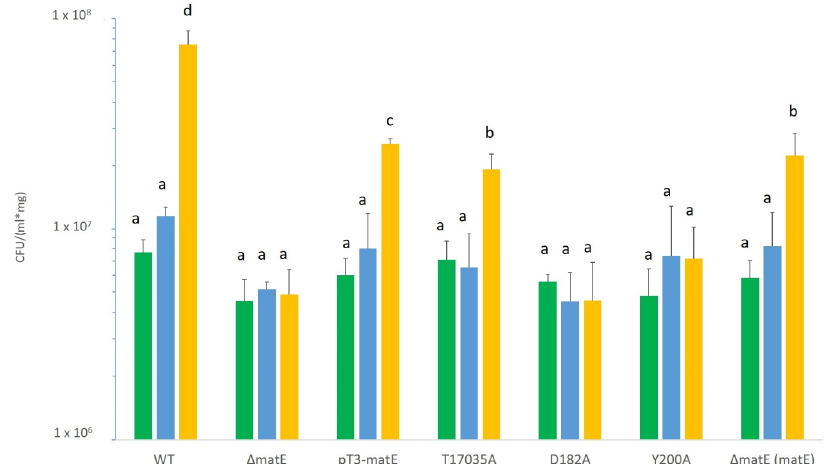
Figure 6. In planta bacterial growth of Psn23 wild type and its mutants ∆ matE , pT3 -matE , D182A, Y200A, and T17035A, at 7 (green), 14 (blue), and 21 (yellow) dpi. Values are the mean of three independent experiments, with nine replicates for run and for each strain ± standard deviation (SD). Different letters indicate statistically significant di ff erences among means at p < 0.05, according to Tukey’s test. Complemented mutant for ∆ matE : ∆ matE ( matE ).